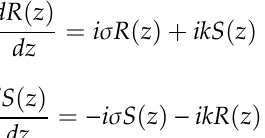
Figure 1. FBG spectra for unembedded and half-embedded cases. Inset shows a schematic representation of the embedment on the 3D-printed structure.